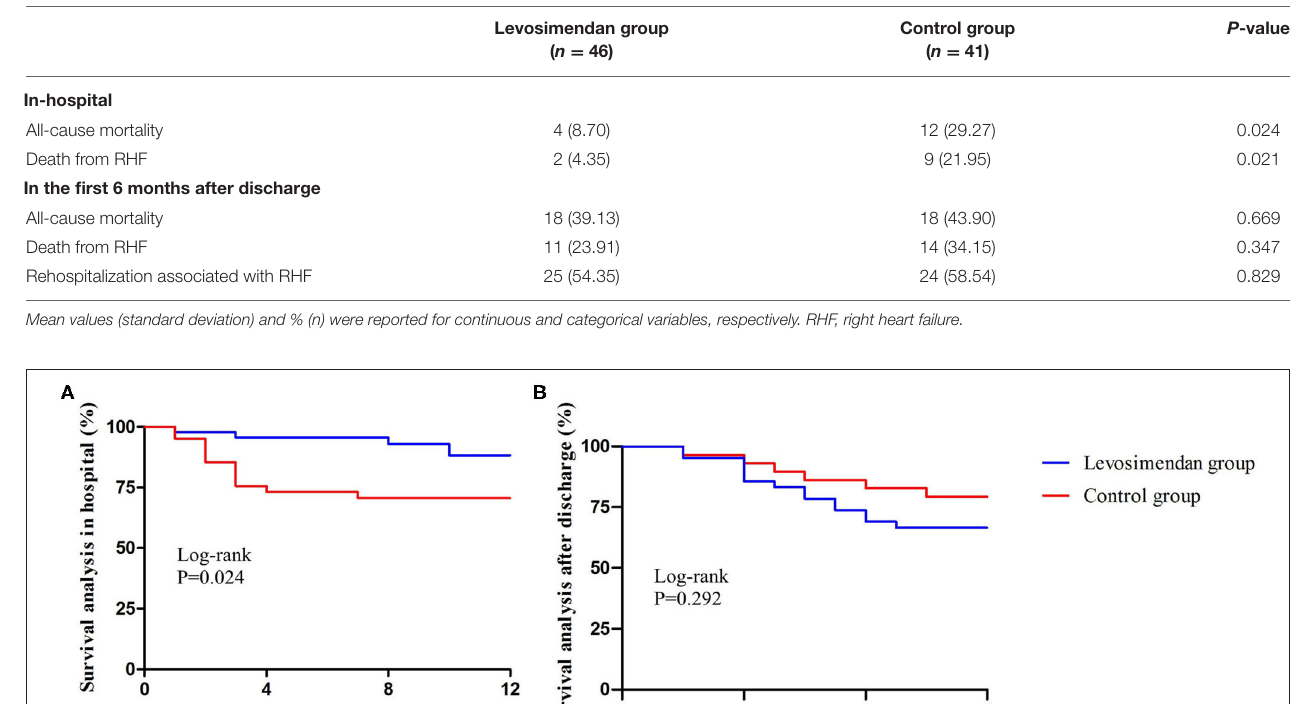
TABLE 3 | Clinical events during hospitalization and in the first 6 months after discharge.